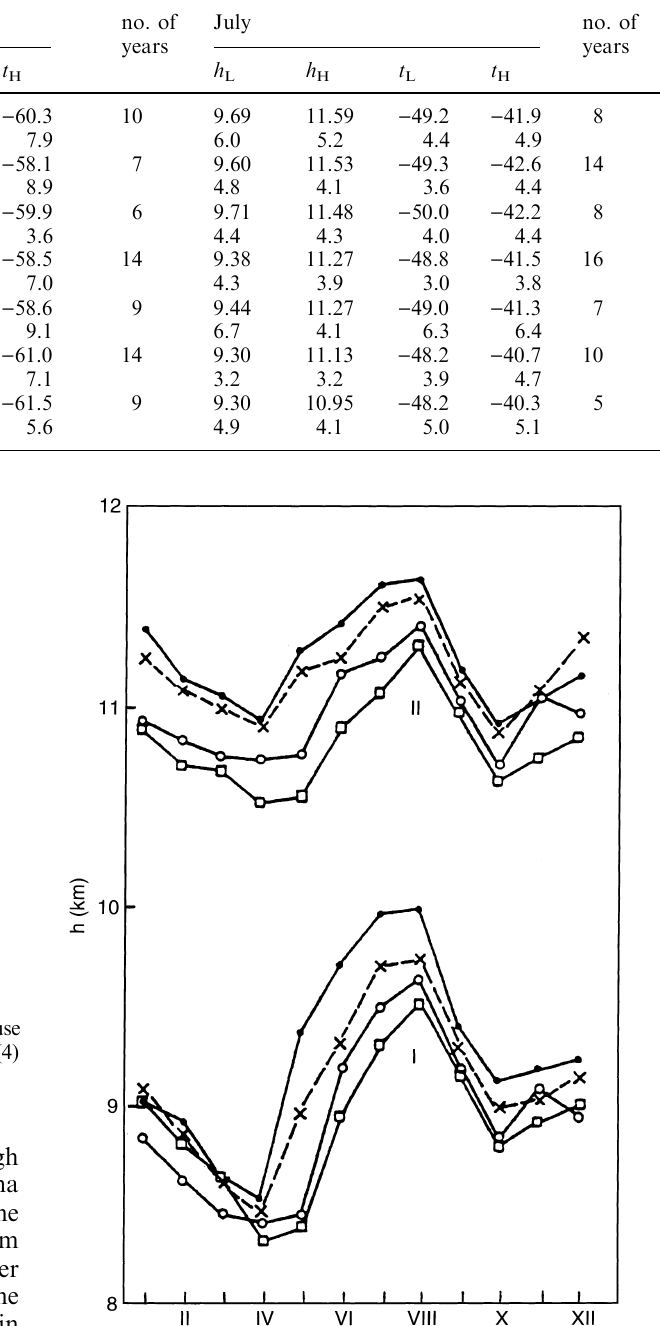
Fig. 3. The height of lower (I) and upper (II) bounds of tropopause over the Arctic Basin: (1) 70 (cid:176) –75 (cid:176) N; (2) 75 (cid:176) –80 (cid:176) N; (3) 80 (cid:176) –85 (cid:176) N;